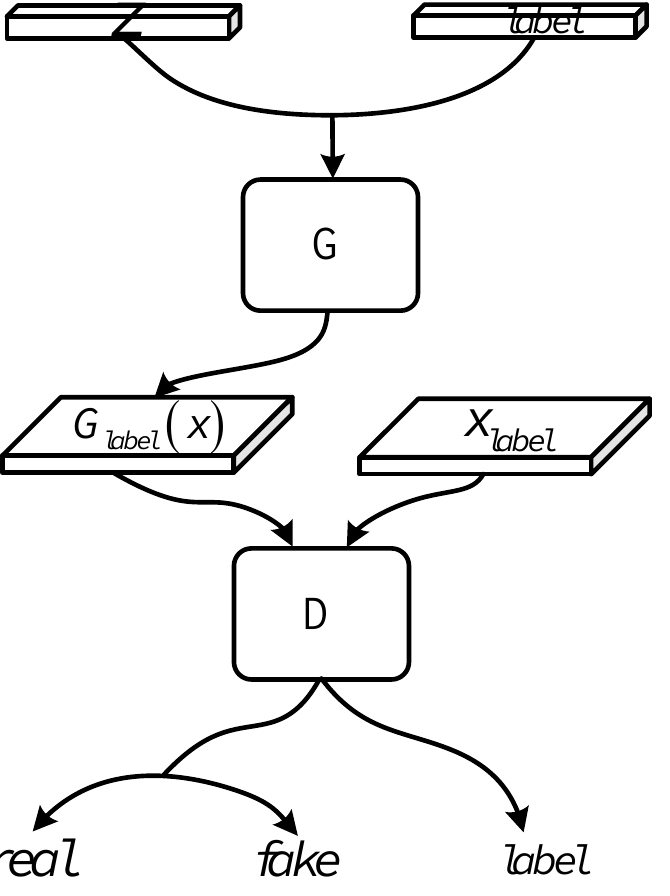
Figure 3. ACGAN Structure Diagram.